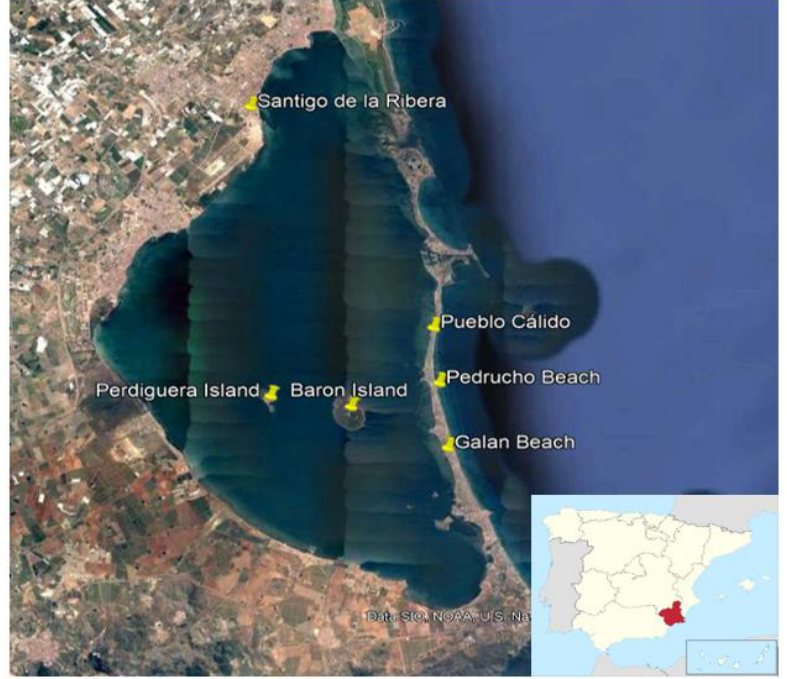
Figure 1. Pinna nobilis sampling sites (Mar Menor, SE Spain).